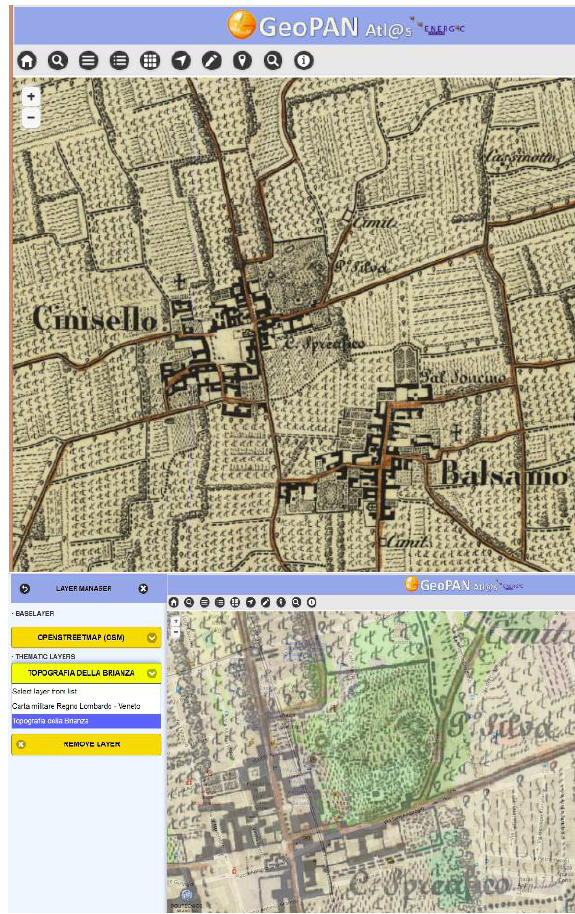
Figure 10. Villa Ghirlanda historic public garden in Cinisello Balsamo (Milan Province). The GEOPAN application allows users to query access and navigate the Brenna’s map (Topografia della Brianza) georeferenced on the current map.